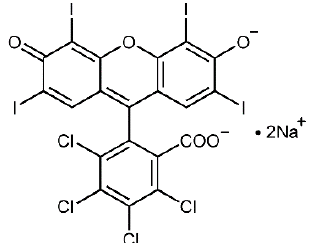
Figure 1. Structural formula of Rose Bengal.